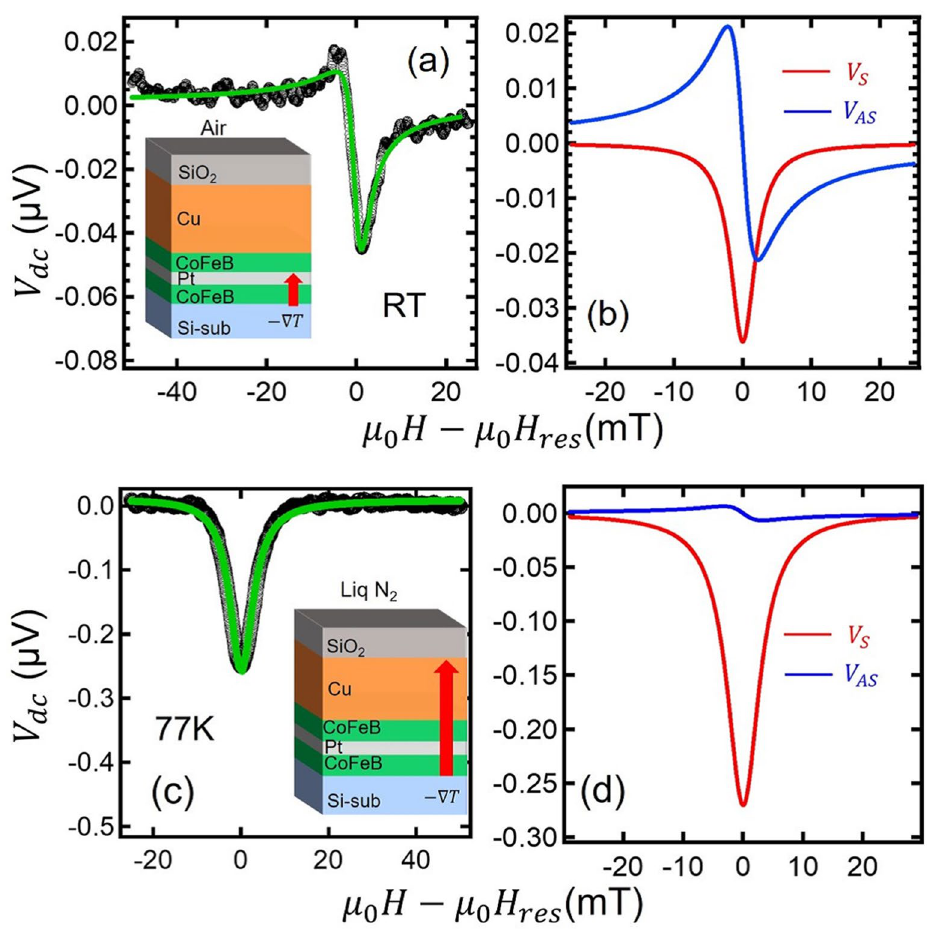
Figure 2. Field dependence of the dc voltage under the microwave with f = 6 GHz measured at ( a ) room temperature and ( c ) 77 K. The solid lines represent the fitting curve using Eq . (2). Separation of the fitting curve into symmetric (red) and anti-symmetric (blue) components for ( b ) room temperature and ( d ) 77